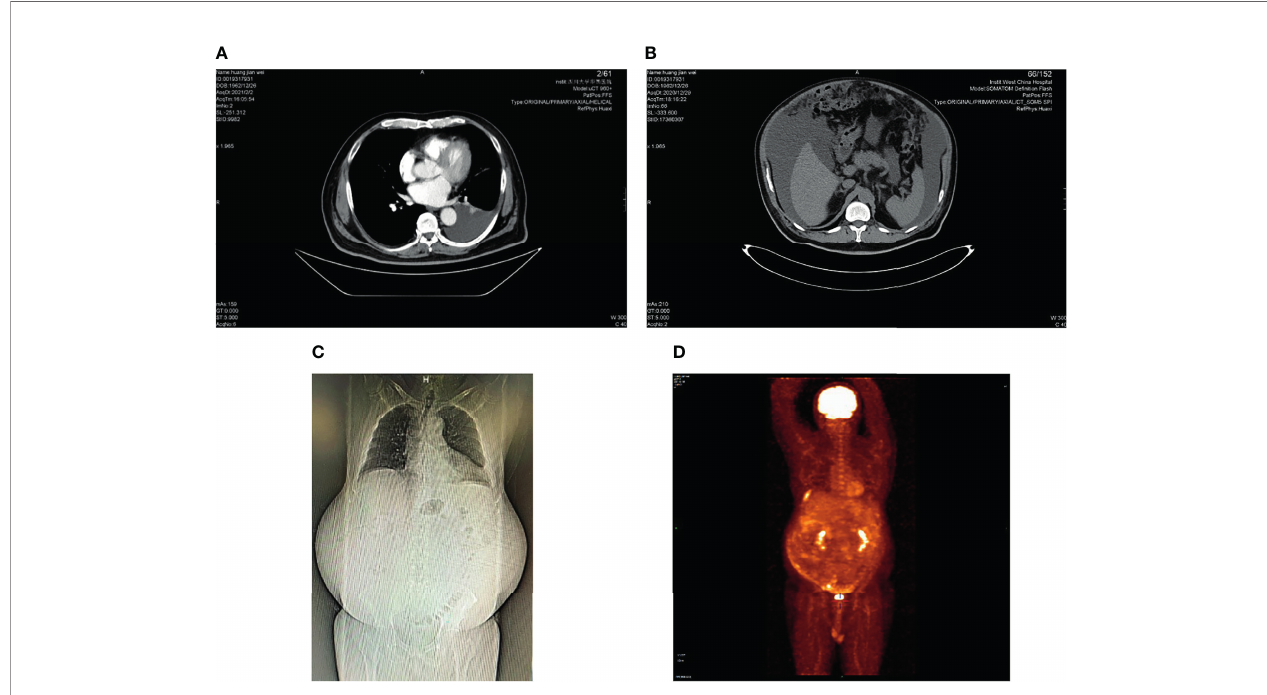
FIGURE 1 | CT and PET-CT photos: (A) left pleural effusion, axial CT scan; (B) massive ascites, axial CT scan; (C) coronal CT scan; (D) PET-CT: there was inhomogeneous peritoneal thickening accompanied by abnormally increased glucose metabolism. We were unsure if this was a tumor or just in fl